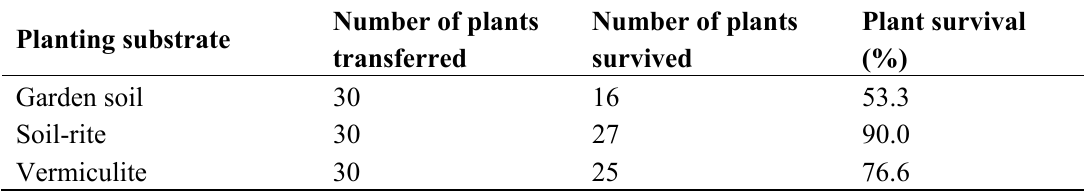
Table 2. Effect of different planting substrates for hardening off synseed-raised plantlets of Rauvolfia serpentina a